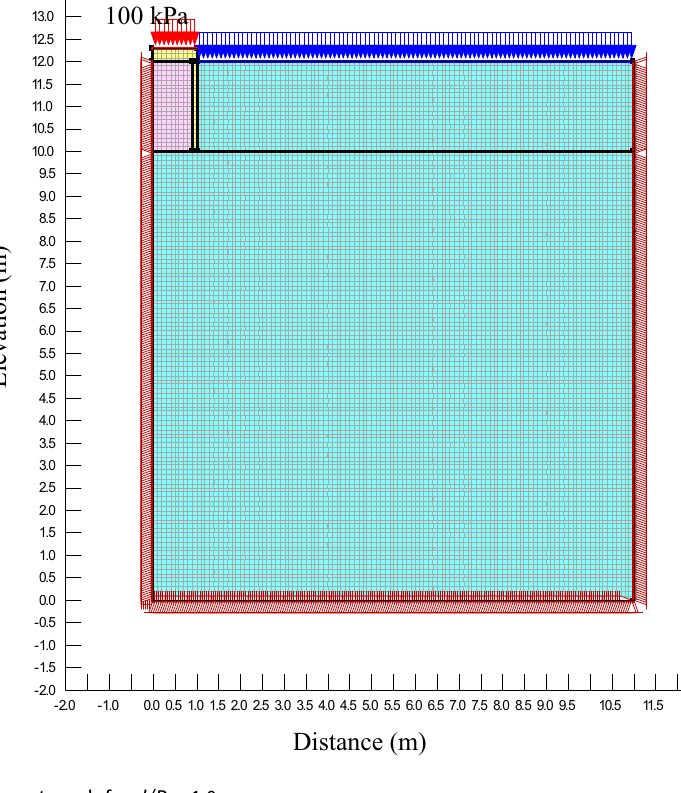
Figure 6: Typical fi nite element mesh for d/D = 1.0.